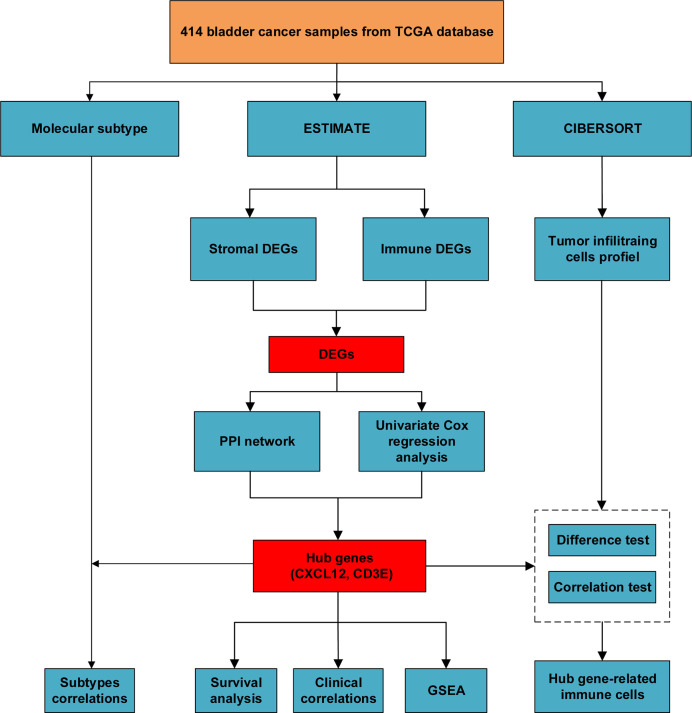
The flow chart of our study of identifying hub genes and their correlations with immune infiltration.